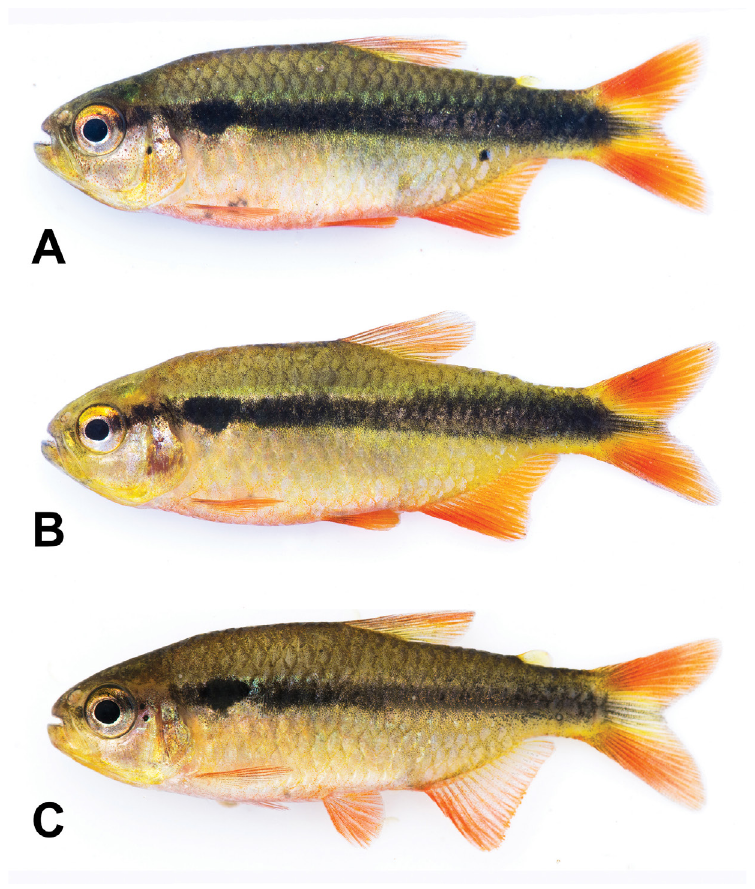
FIGURE 2 | Live coloration of Hyphessobrycon comodoro , Brazil, Mato Grosso State, Municipality of Comodoro, rio Mutum, upper rio Juruena basin: A. Holotype, MZUSP 125904, 29.6 mm SL, male; B. Paratype, MZUSP 125215, 27.4 mm SL, male lacking adipose fin; C. Paratype, MZUSP 125215, 29.8 mm SL,